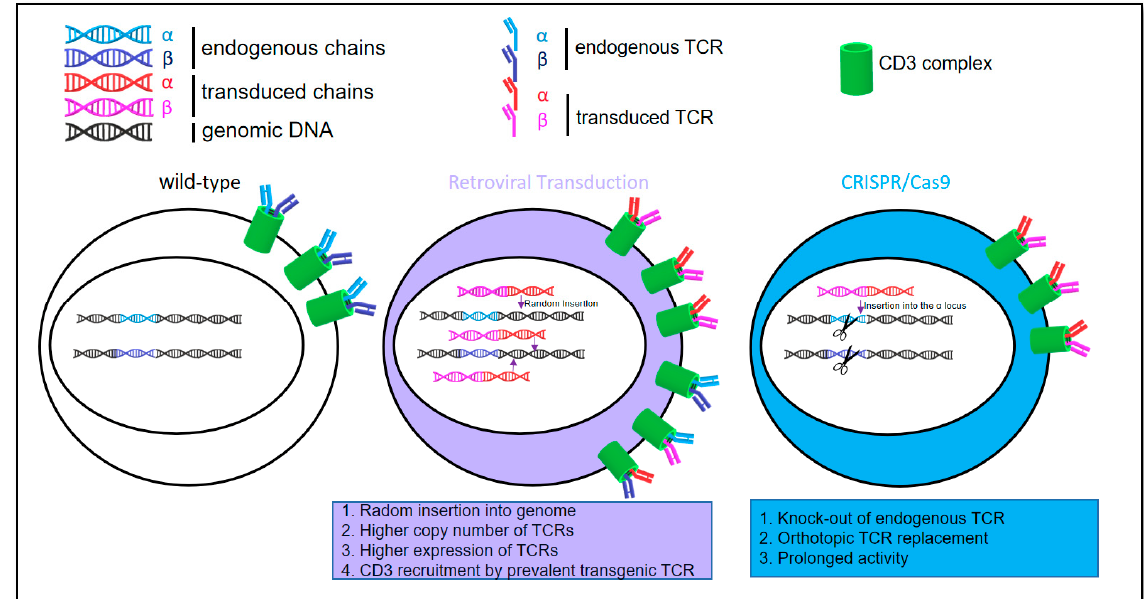
Figure 1. Graphical abstract illustrating the comparison of CRISPR/Cas9-engineered orthotopic TCR replacement or retrovirus transduced random TCR insertion into the T cell genome. replacement or retrovirus transduced random TCR insertion into the T cell